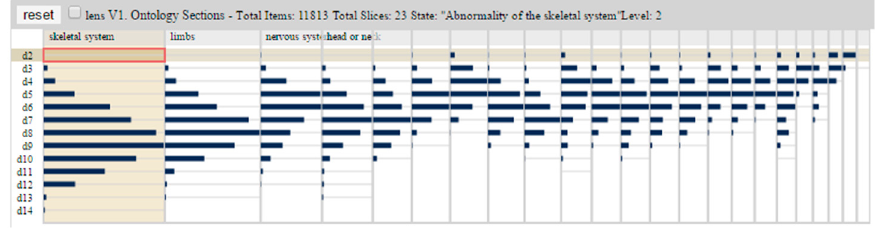
Figure 20. The initial stage of the Ontology Sections Panel